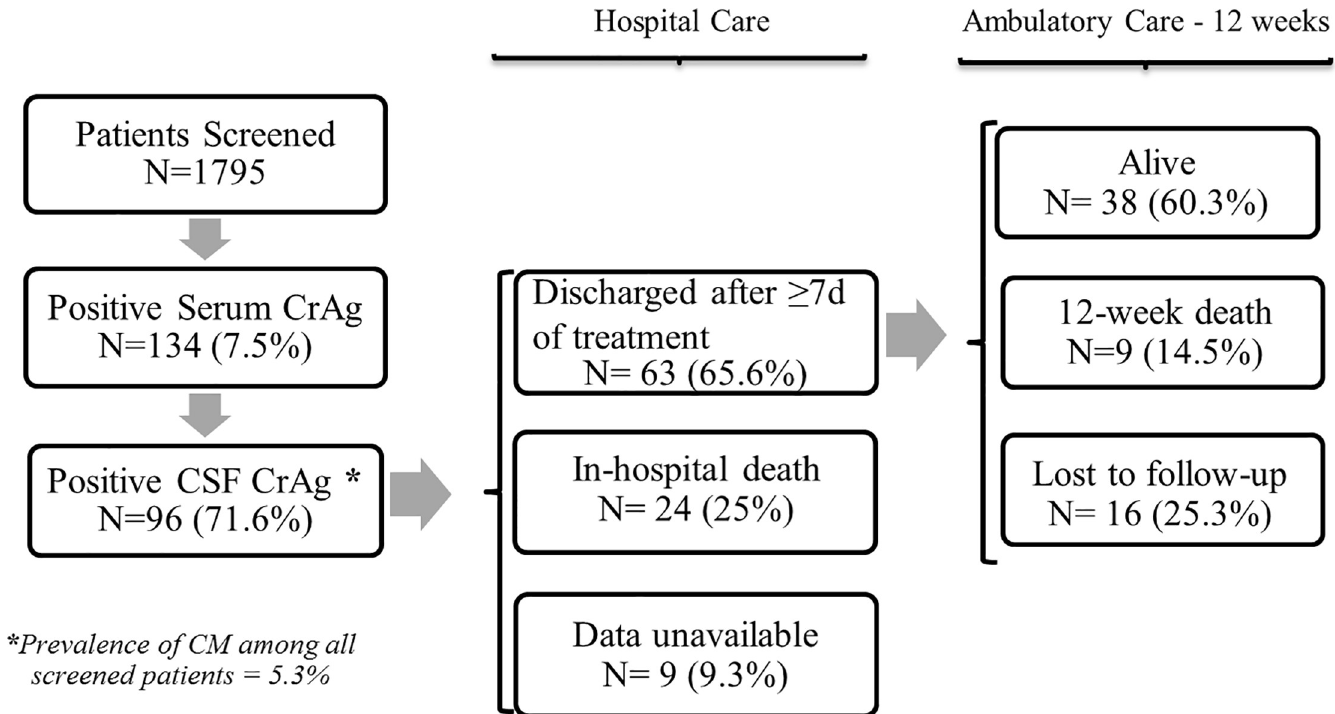
Fig 1. Flow diagram for patients screened and diagnosed with cryptococcal meningitis, in-hospital and 12-week